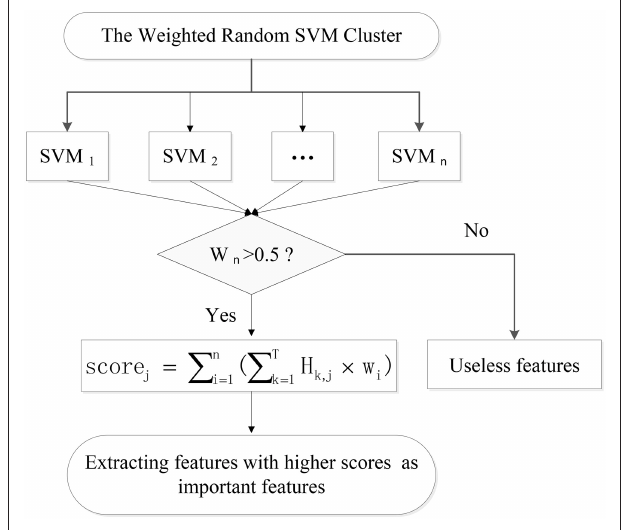
FIGURE 3 | The extraction of important